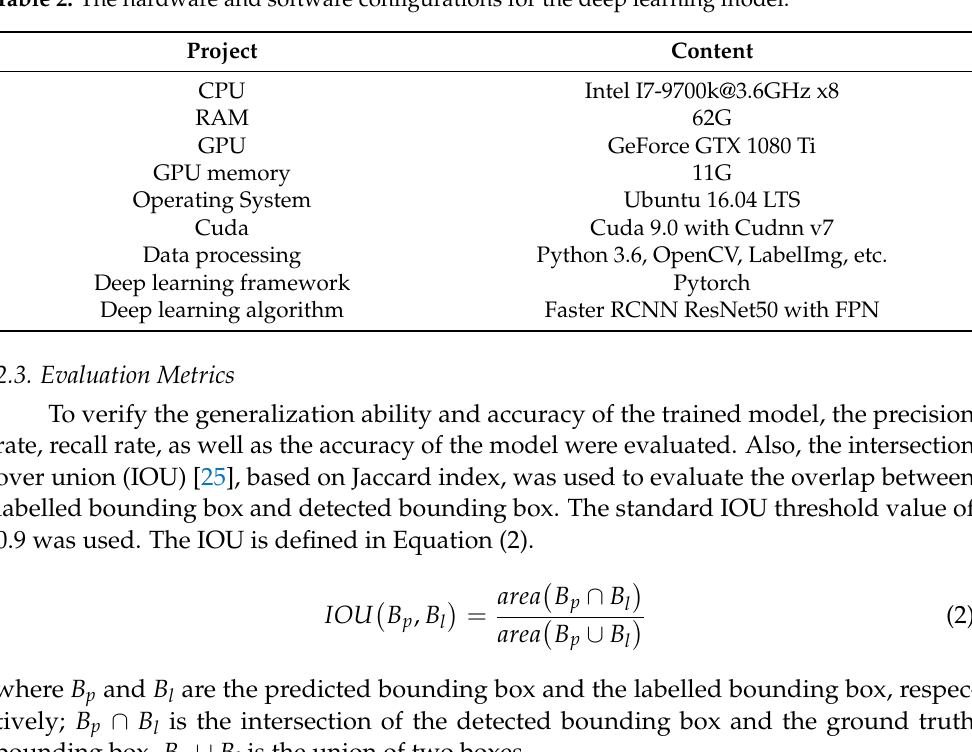
Table 2. The hardware and software configurations for the deep learning